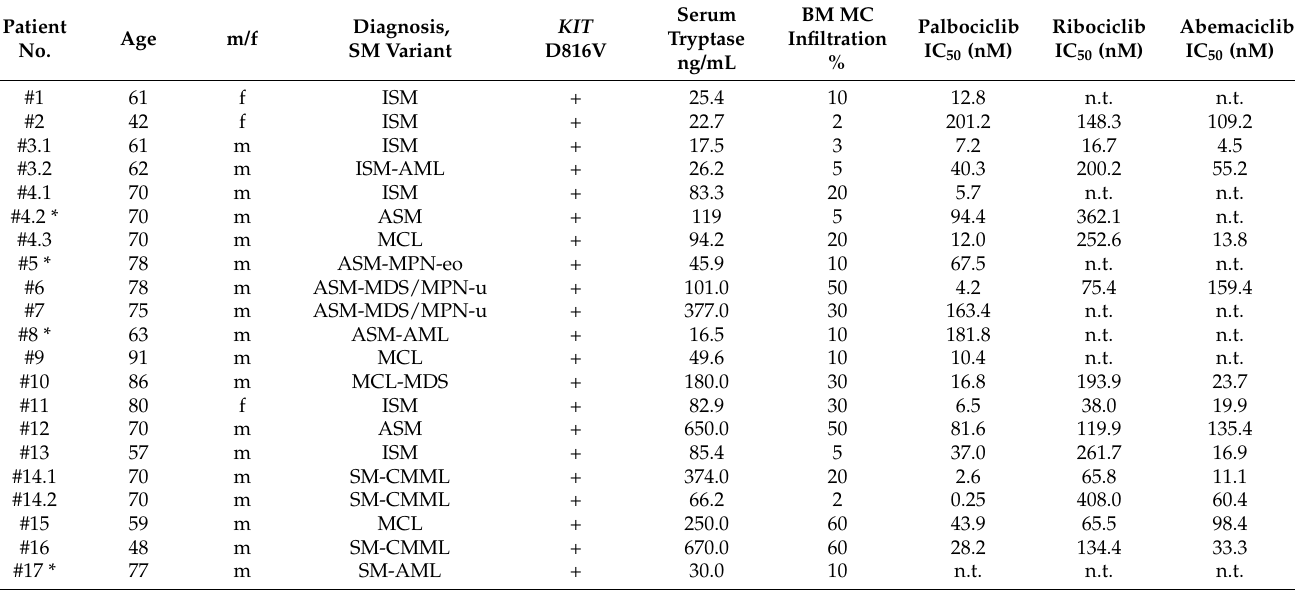
Table 1. Patients’ characteristics (SM patients) and responses of neoplastic cells to CDK4/CDK6 inhibitors. Patient